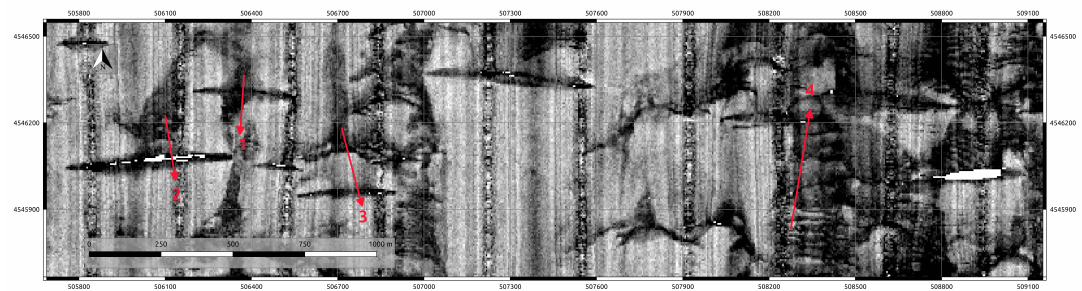
Figure 36. Acoustic Backscatter (BS) collected in 1998 (Simrad Subsea EM 1000 Multibeam Echo Sounder, 95 kHz), dark area low BS. Lines numbered 1–4 indicate the transects used to plot the vertical profiles in Figure 35)